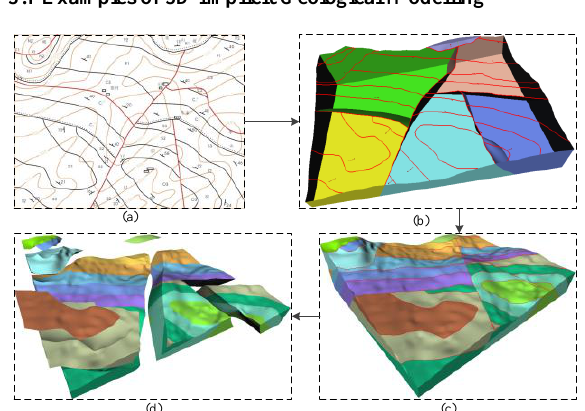
Figure 5. 3D regional geological modelling containing typical structures (folds, faults) from the 2D geological map; (a) 2D geological map; (b) geological framework modelling based on fault data; (c) integral regional geological model; (d) explosive view of geological